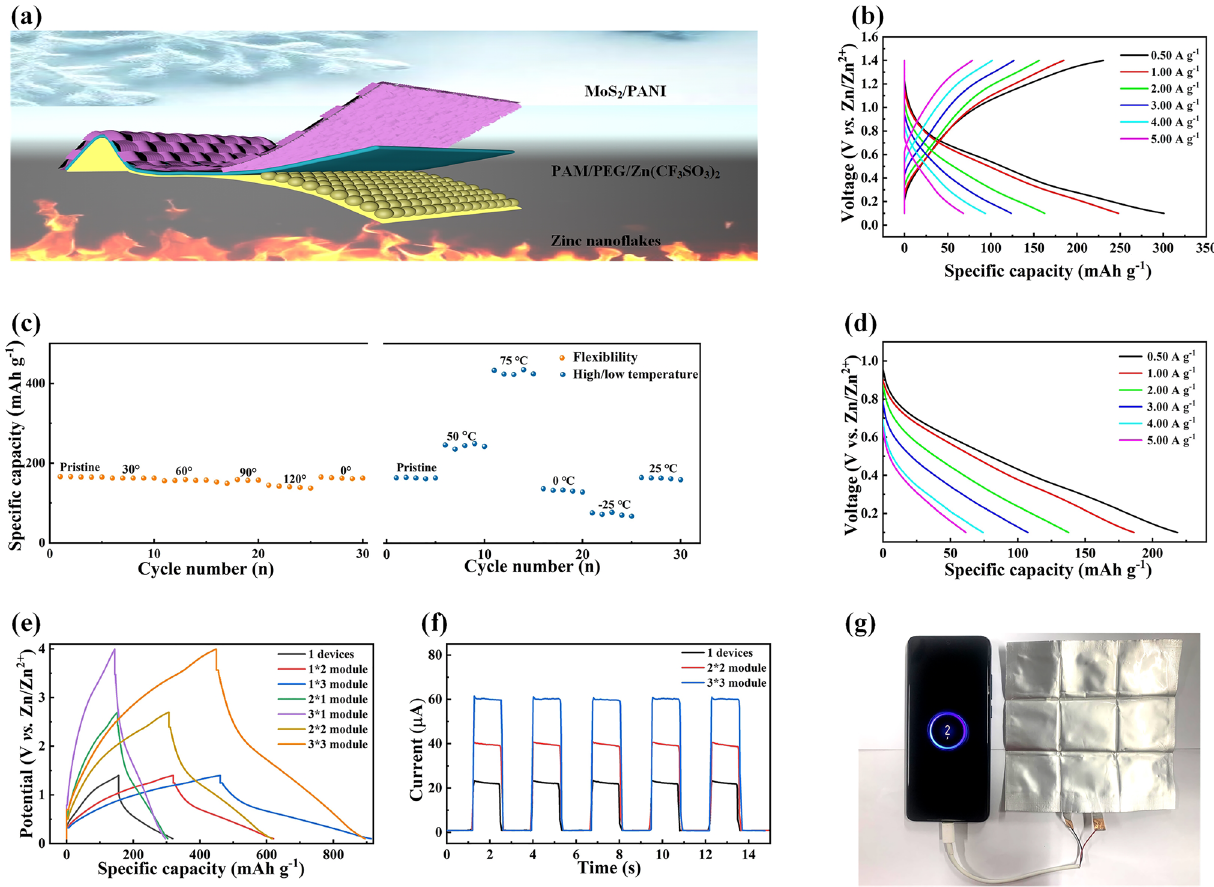
Fig. 6 Practicability of MoS 2 /PANI cathode. a Schematic diagram and b GCD curves of the QSZIBs. c Specific capacity at 2.00 A g −1 of QSZIBs under bent or high and low temperatures. d Galvanostatic discharging curves of QSZIBs after 24.0-h air recharging. e GCD curves at 2.0 A g −1 of QSZIB module. The QSZIB module powered for f pressure sensors and g